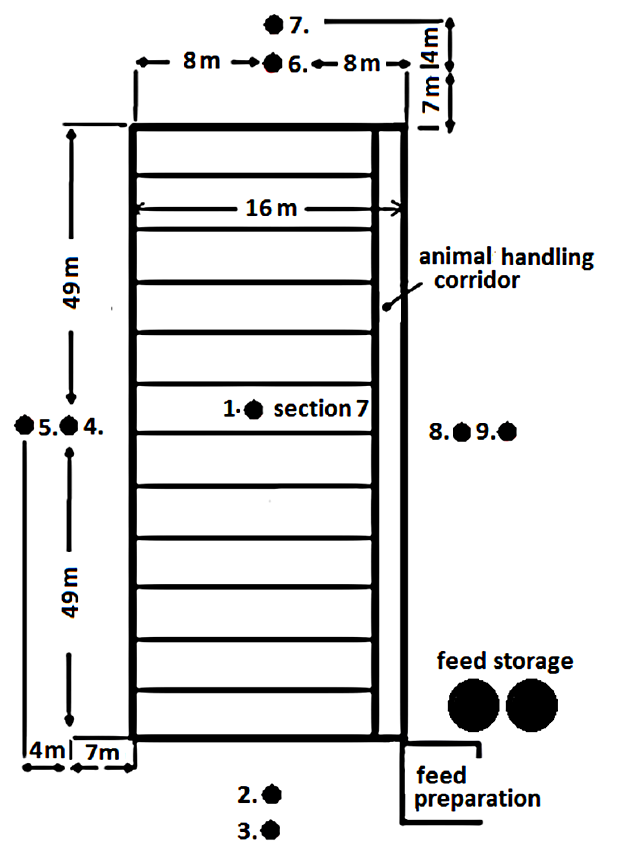
Figure 1. Schematic plan of monitored object with places of mea- surement